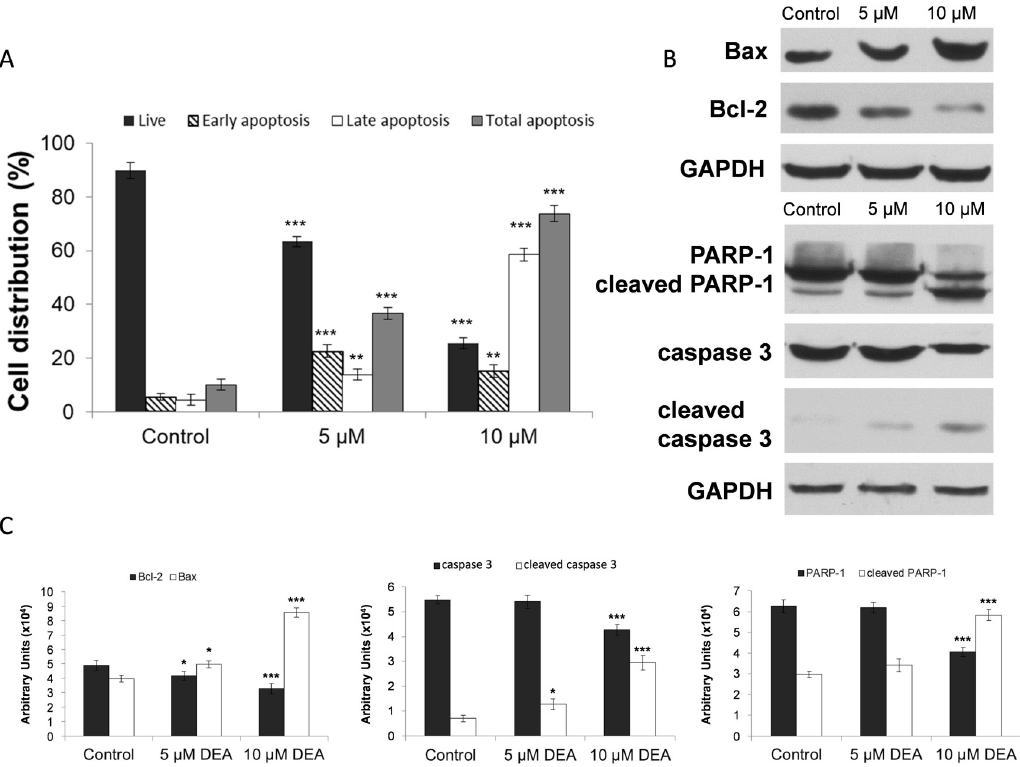
Fig 3. Effect of DEA on activation of apoptosis in B16-F10 cells. After subjected to 24 hours treatment with increasing concentrations of DEA the cells were stained with the Muse ™ Annexin V & Dead Cell Reagent and measured on the Muse ™ Cell Analyzer. (A) The bar chart shows the percent distribution of living (dark gray bars), early apoptotic (striped bars), late apoptotic (white bars) and total apoptotic cells (light gray bars). Controls were treated with vehicle (0.2% DMSO). (B) Immunoblot analysis on total cell lysates was performed using antibodies against Bax, Bcl-2, PARP-1, caspase 3 and cleaved caspase 3. The results of the immunoblot analysis and the densitometric analysis of the immunoblots are presented in panels B and C. The experiments were repeated three times in at least quadruplicate, and the results are expressed as the mean ± SD. Data were analyzed using ANOVA with Dunett post hoc test (A) and with Mann-Whitney U test (C). � p � 0.05, �� p � 0.01 and ��� p � 0.001 compared to the corresponding control